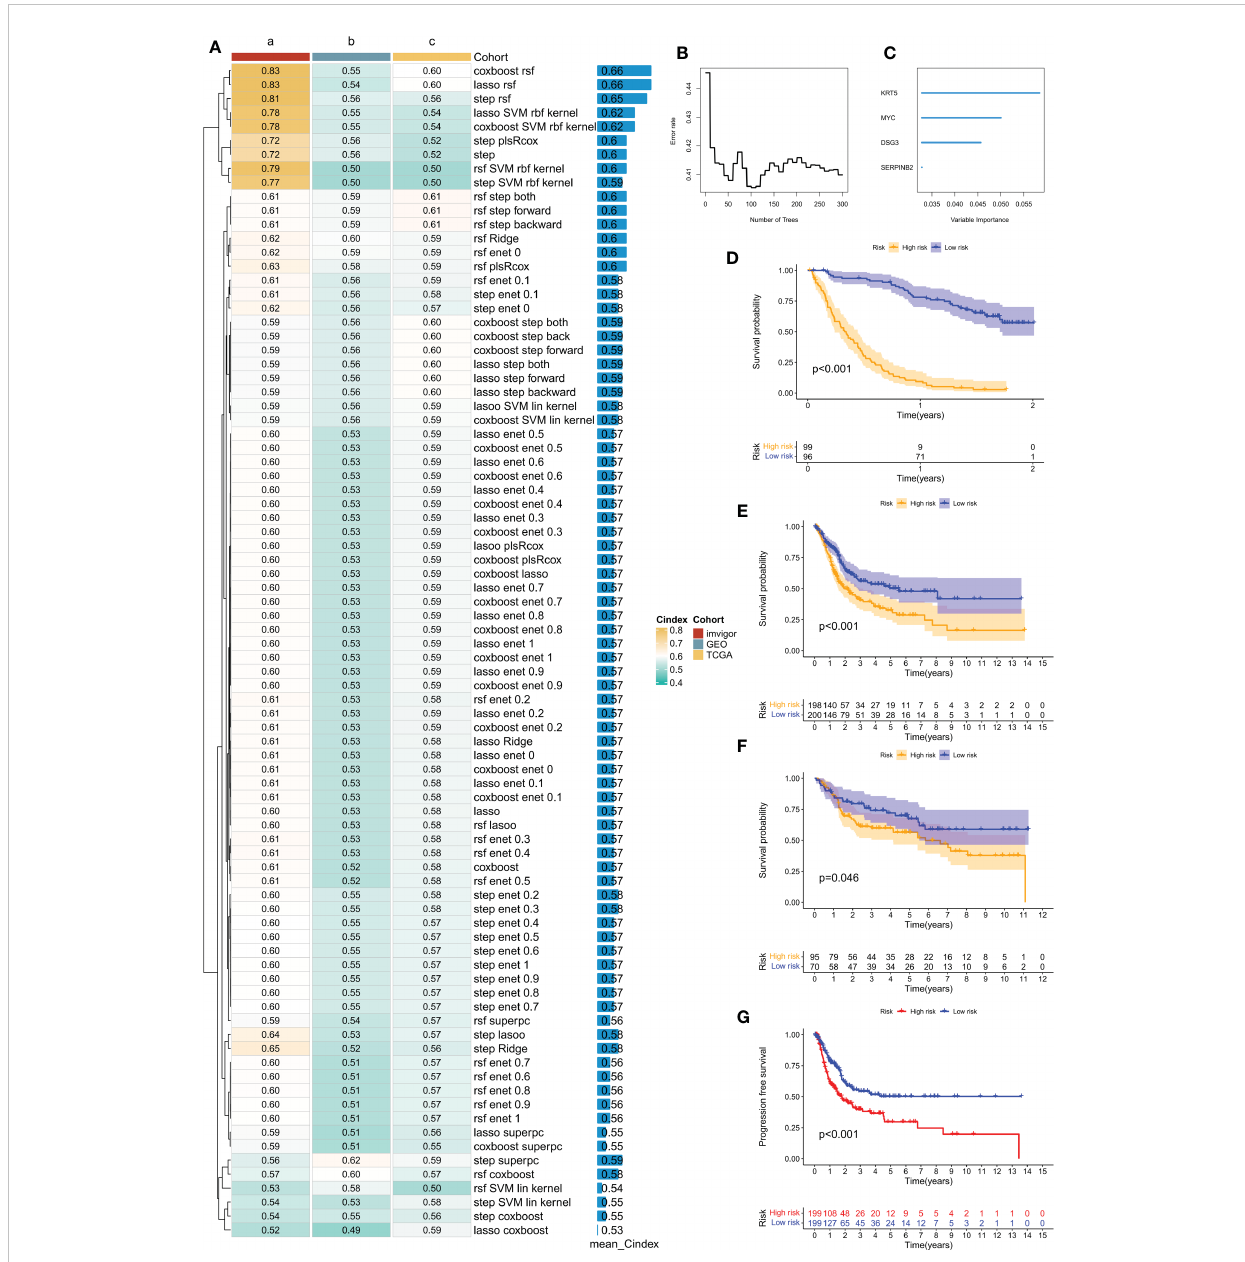
FIGURE 5 Prognostic features related to disul fi dptosis constructed through machine learning-based integration and their prognostic value. (A) 84 integrated prediction models based on machine learning were fi tted using 10-fold cross-validation. The C-index was computed for each model in both the training and validation cohorts, which included TCGA-BLCA, iMvigor210, and GSE13507 cohorts. (B) The number of trees determined by minimum error. (C) Importance of the four most valuable genes based on the RSF algorithm. (D – F) Kaplan-Meier survival curves of overall survival (OS) for high-risk and low-risk groups of patients in the iMvigor210, TCGA-BLCA, and GSE13507 cohorts, respectively. (G) Kaplan-Meier survival curve of progression-free survival (PFS) for high-risk and low-risk groups of patients in the TCGA-BLCA